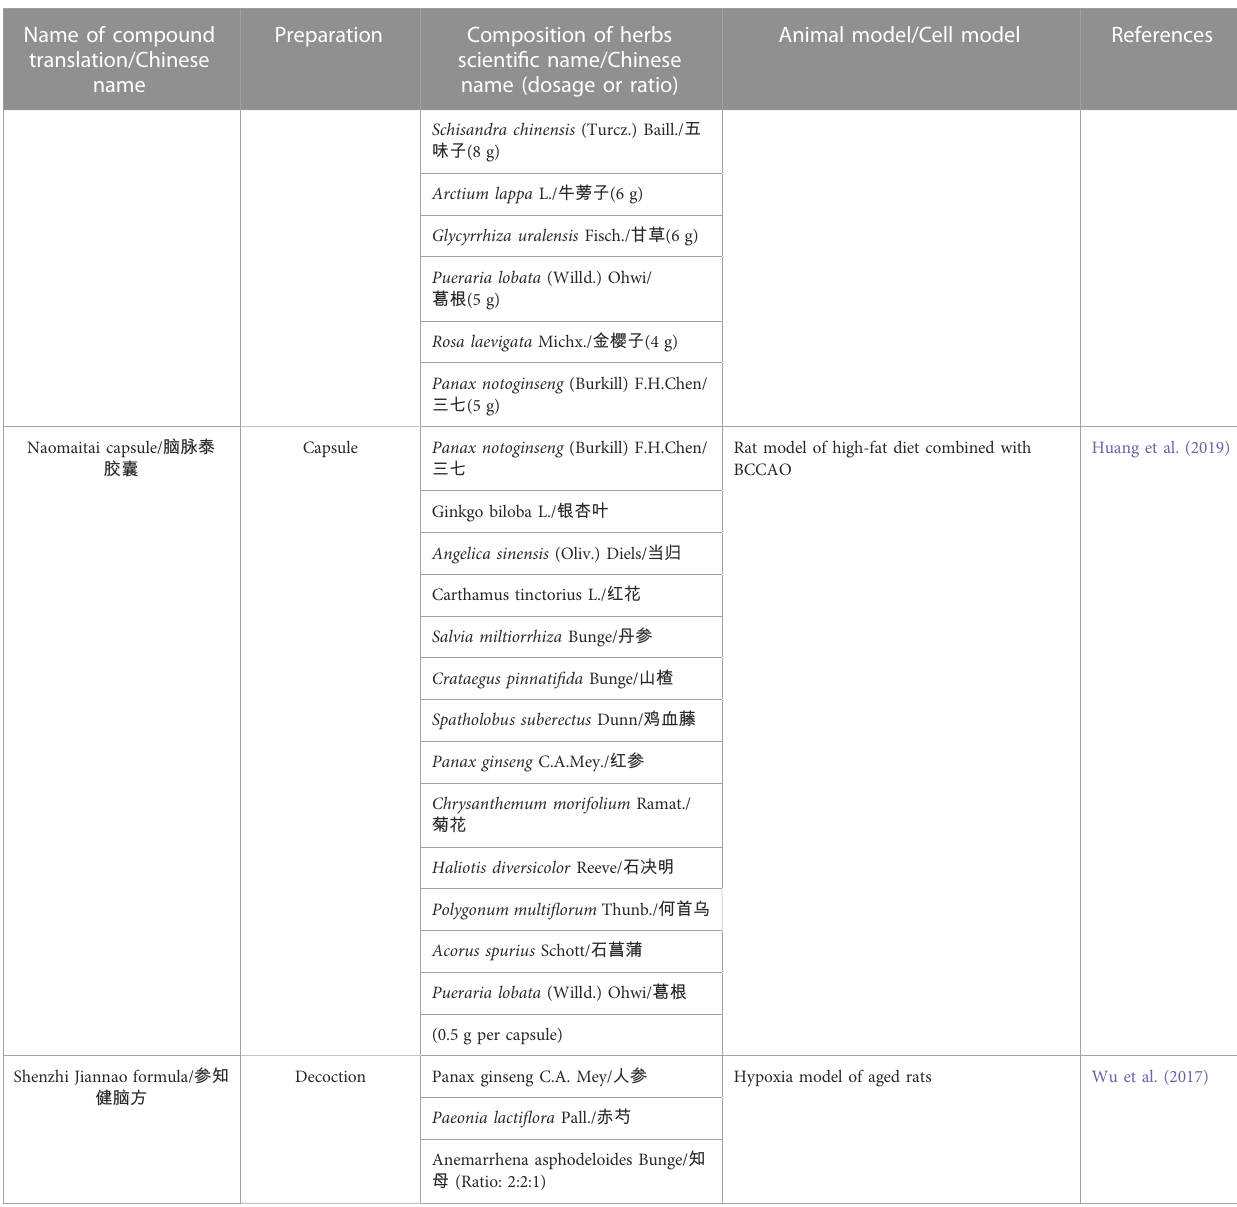
TABLE 1 ( Continued ) Composition of Chinese herbal compounds targeting mitochondria after